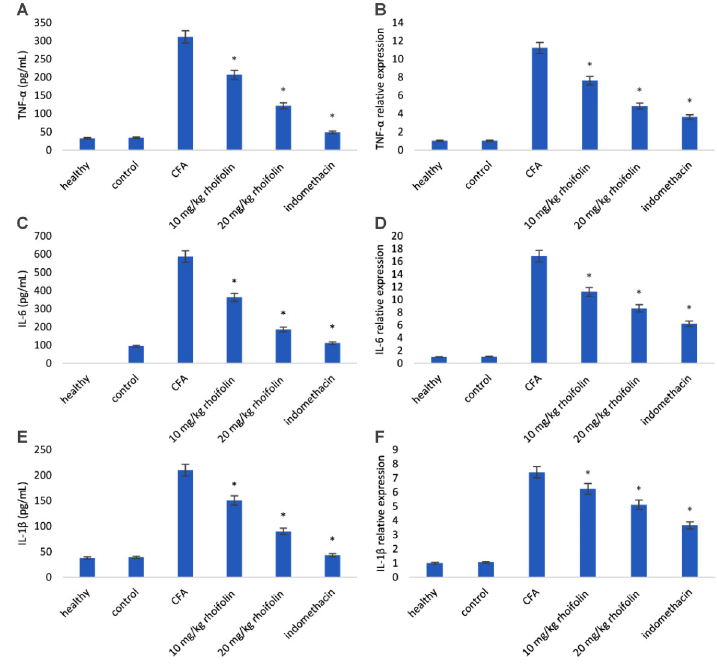
Figure 4. Effect of rhoifolin treatment levels of tumor necrosis factor (TNF)- a and relative expression ( A and B ), interleukin (IL)-6 and relative expression ( C and D ), and IL-1 b and relative expression ( E and F ). Data are reported as means ± SE. *P p 0.05 compared to complete Freund ’ s adjuvant (CFA)-induced group